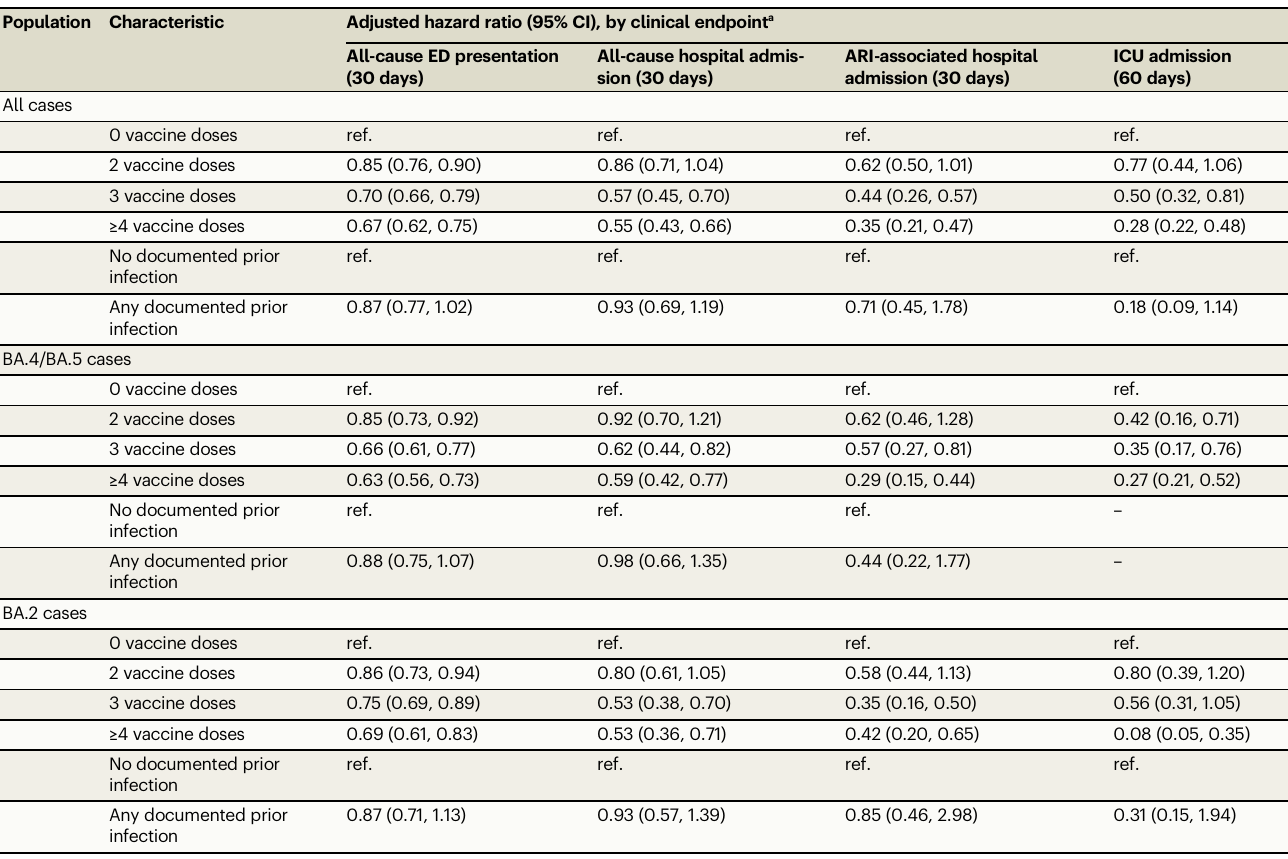
Table4 |Associationofpriorvaccinationorinfectionwith riskofsevere clinicaloutcomes among casestested 29April,2022to 29 July, 2022 Population